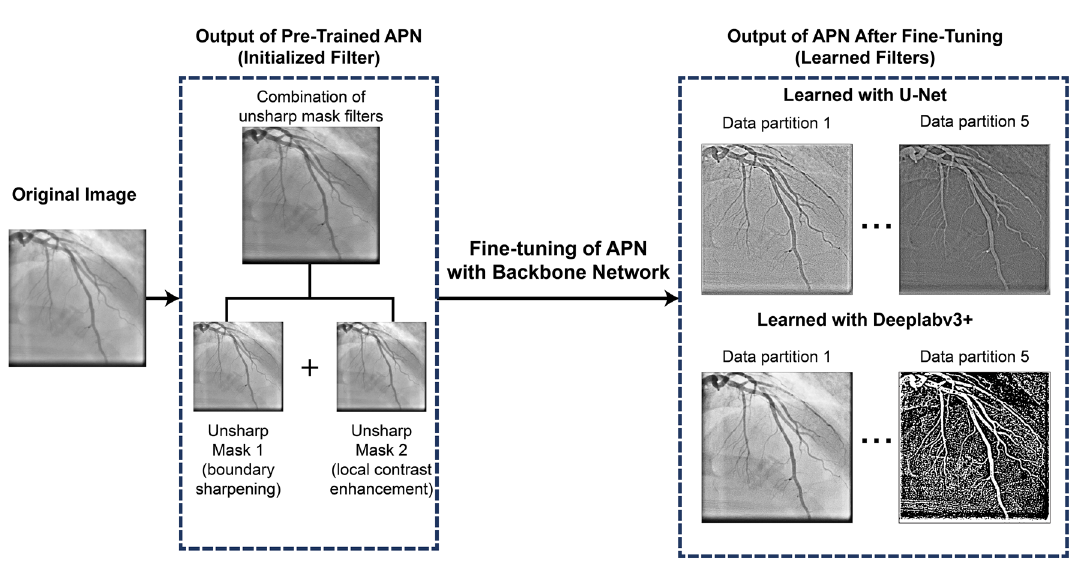
Figure 4. Examples of learned filters when the APN is fine-tuned together with Deeplabv3+ and U-Net. The APN was initialized with the combination of unsharp mask filters shown above, and learned new filters to aid segmentation. Each example image is the output of the APN after training with different data